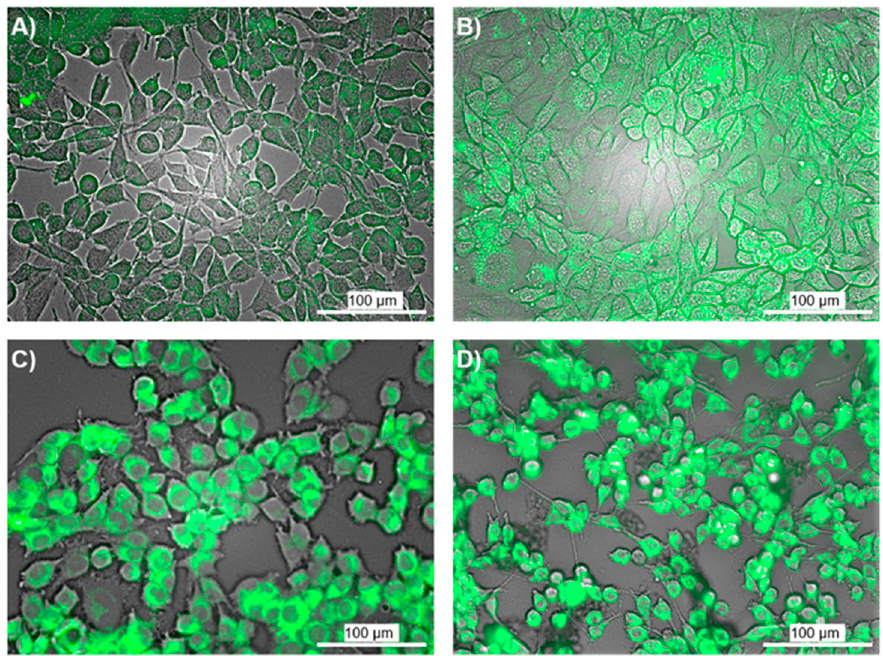
Figure 4. Fluorescence microscopy images of U87 cells after incubating with PEGNIO/QDs/MIONs (( A ): without MT; ( B ): with MT) and PEGNIO/QDs/MIONs/Tf (( C ): without MT; ( D ): with MT). The quantification procedure was evaluated with p < 0.05, and is therefore significant.